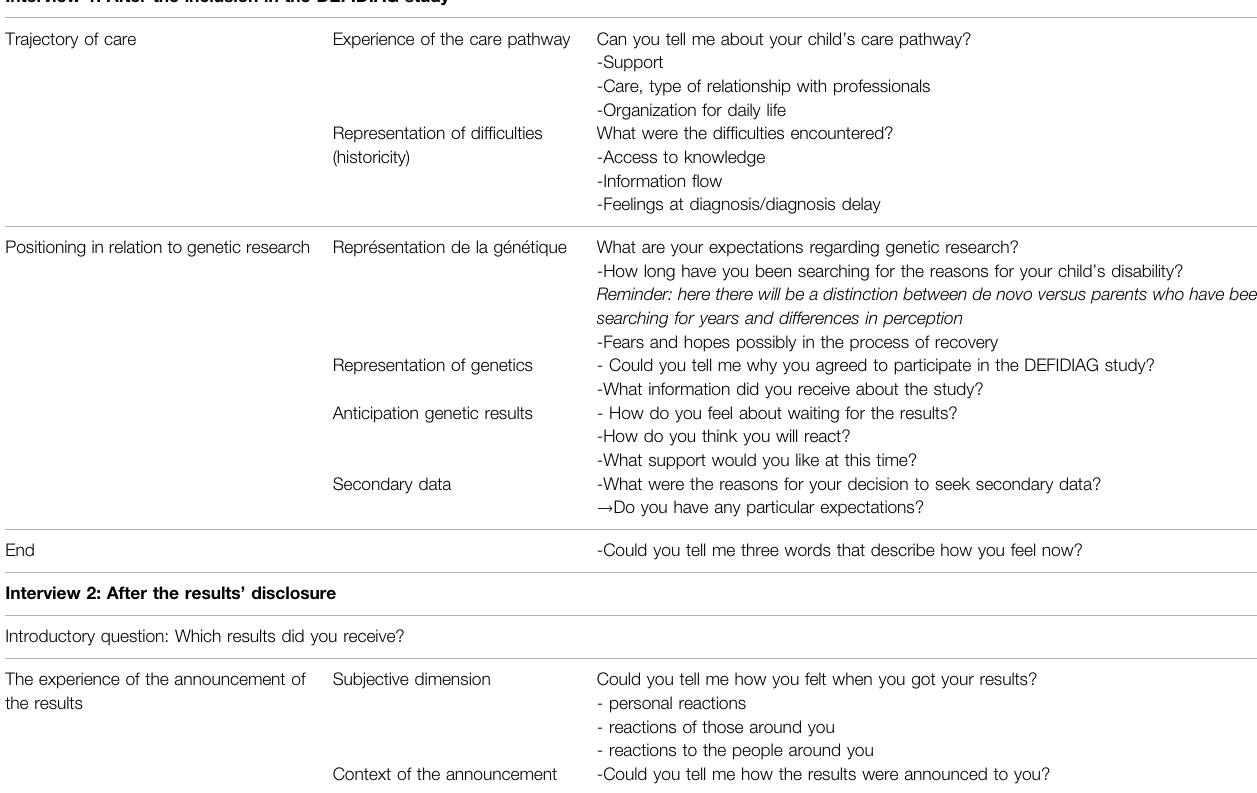
TABLE 1 | Template of the qualitative study. Interview 1: After the inclusion in the DEFIDIAG study Trajectory of